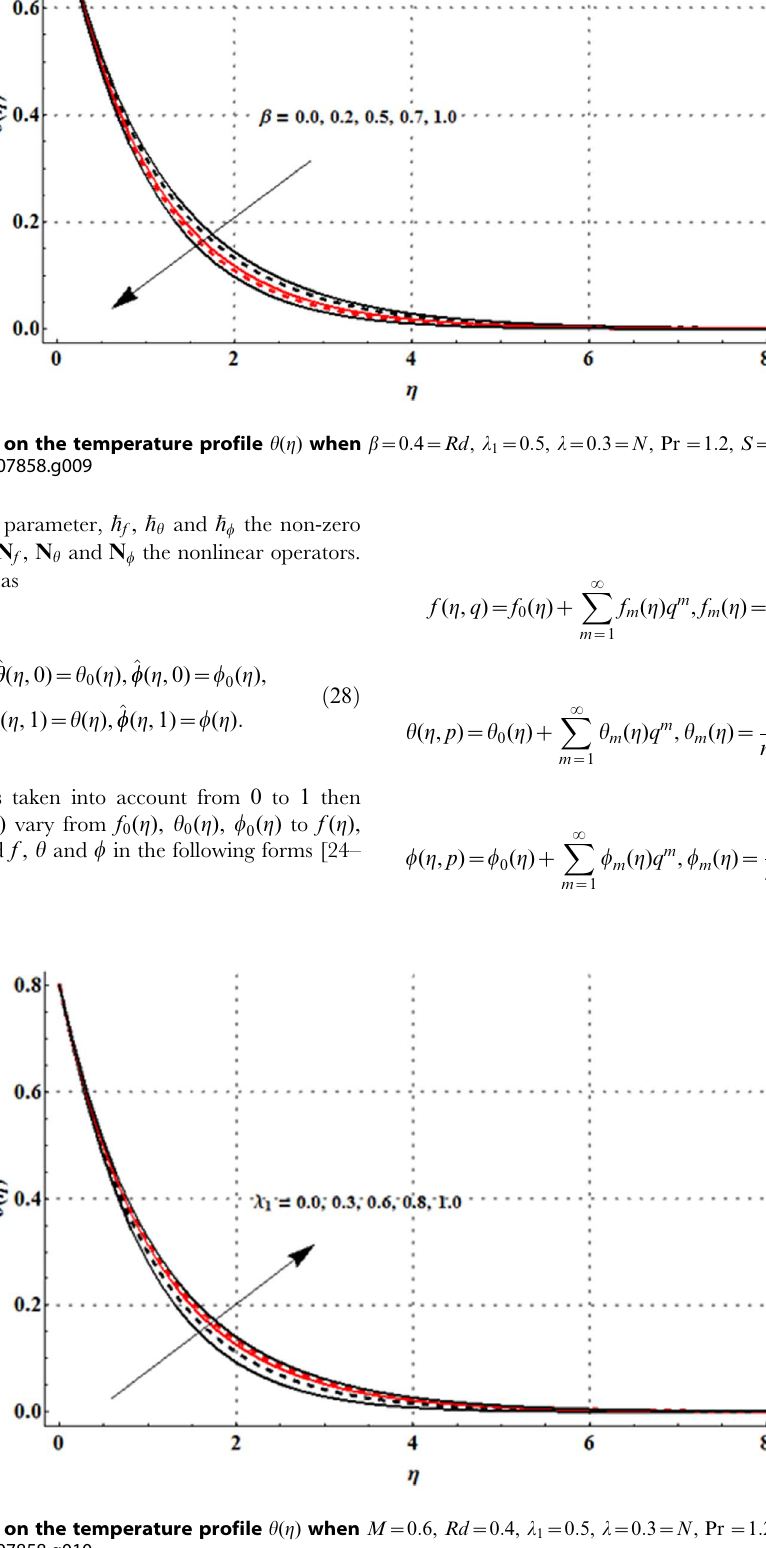
Figure 10. Influence of b on the temperature profile h ( g ) when M ~ 0 : 6, Rd ~ 0 : 4, l 1 ~ 0 : 5, l ~ 0 : 3 ~ N , Pr ~ 1 : 2, S ~ 0 : 2 ~ S (cid:2) and Sc ~ 1 : 0 :